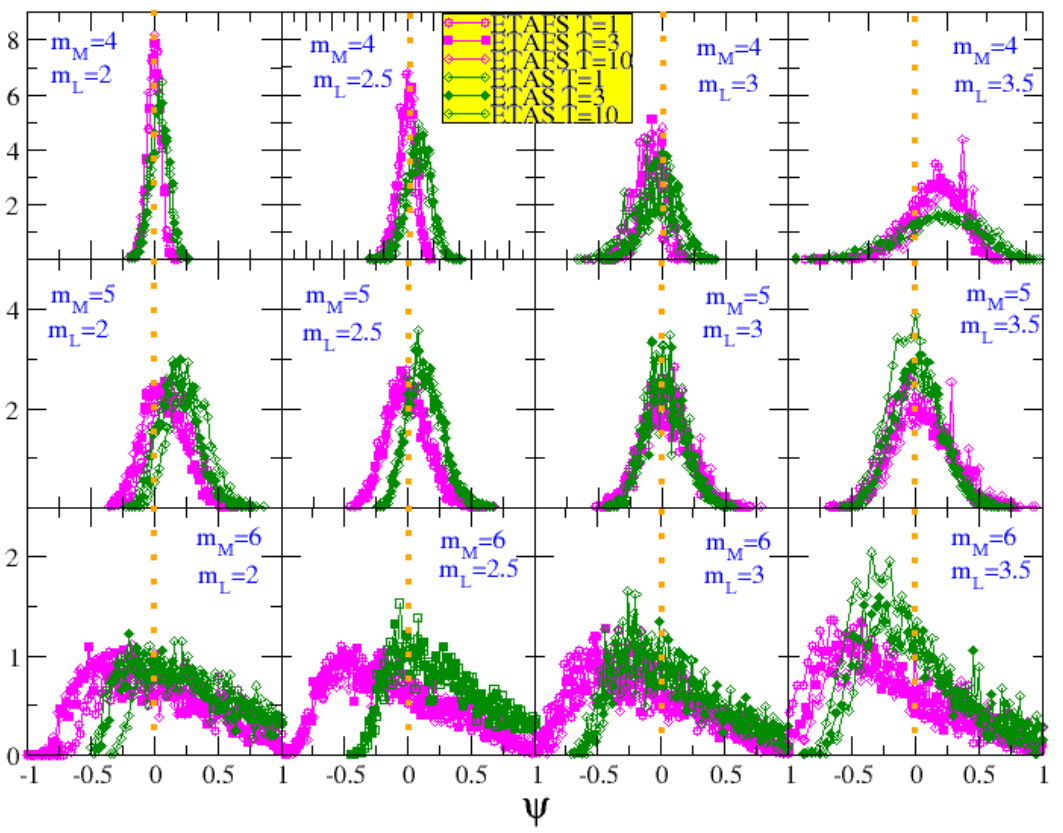
Figure 4. The fraction of numerical subsets H ( ψ ) of the ETAFS (ETASI) and ETAS simulated catalogue, n X A , j ( T , R , m L , m M ) − n A ( T , R , m L , m M ) = ψ ± 0.005. Results are for different with a number of aftershocks n X A , j ( T , R , m L , m M )+ n A ( T , R , m L , m M ) values of the time window T . Moving horizontally, from left to right, m L = 2,2.5,3,3.5 whereas vertically, from top to bottom, m M = 4,5,6. The orange dashed line indicate the optimal description of the seismicity ψ =